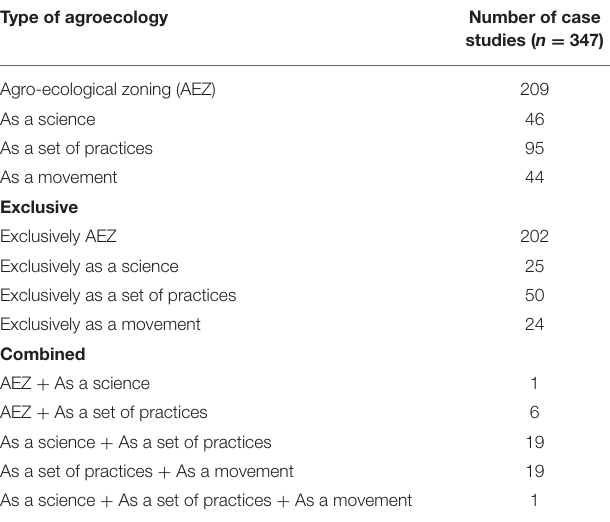
TABLE 3 | Type of agroecology referred to in the selected case